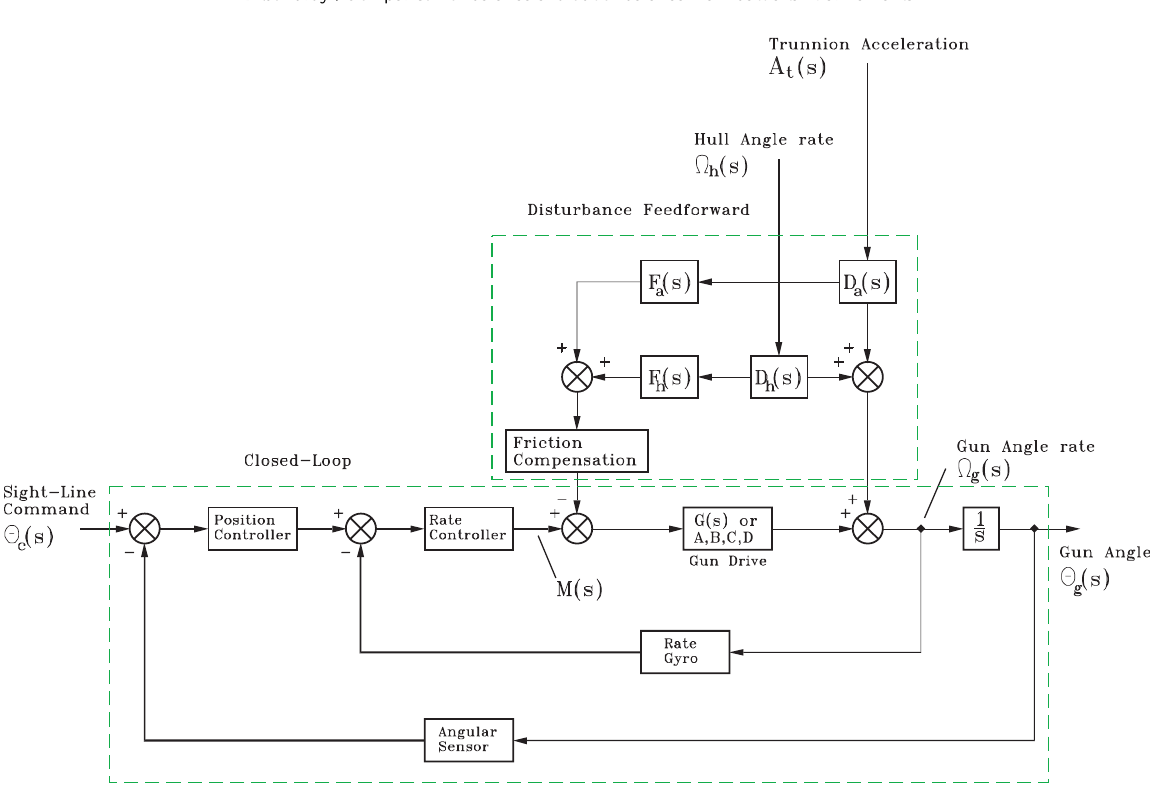
Fig. 4. Controller structure for the OOB and balanced weapon control